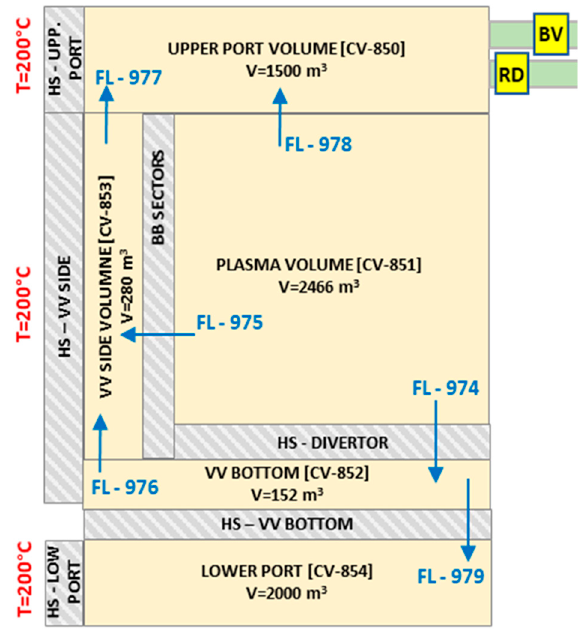
Figure 7. MELCOR Vacuum Vessel nodalization scheme.